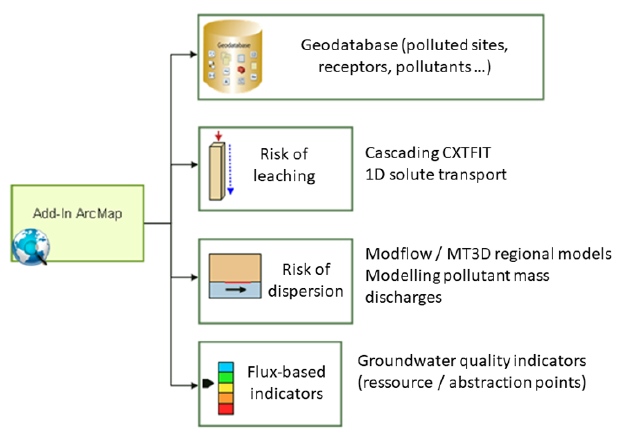
Figure 6. Framework of regional approach to assess and control the pollution risk associated with the cumulative effect of a series of pollution sources (adapted from Jamin et al., 2012; © HGE- Université de Liège